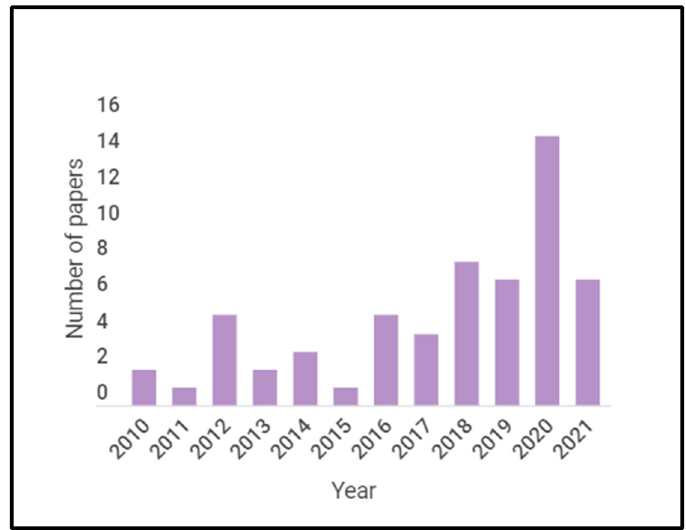
Figure 6. Distribution of the 60 papers during 2010–2021.